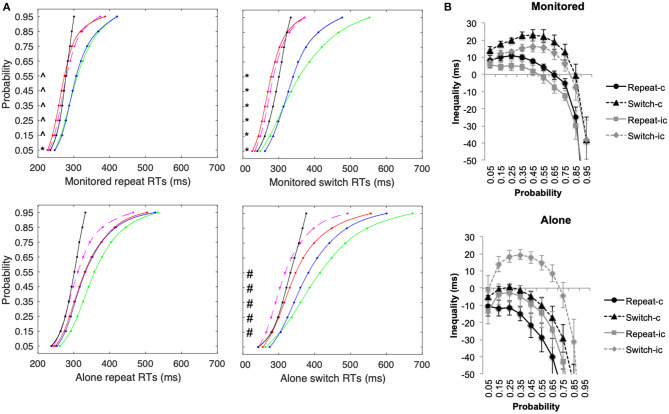
Experiment 2 (A) Cumulative density functions (CDFs) for the unisensory auditory (green line), visual (blue line) stimuli, and the multisensory congruent (AV-c: red line) and incongruent (AV-ic: dashed magenta line) and the summed probability for the unisensory stimuli (AT+VT CDF—i.e., test of inequality: black line) for repeat and switch conditions. (B) Mean difference (±SEM) between the AVT CDF and the bound AT+VT CDFs for repeat and switch conditions for congruent and incongruent trials. *both AVT-c and AVT-ic significantly faster than AT+VT CDF, ∧only AVT-c significantly faster than AT+VT CDF, #only AVT-ic faster than AT+VT CDF.